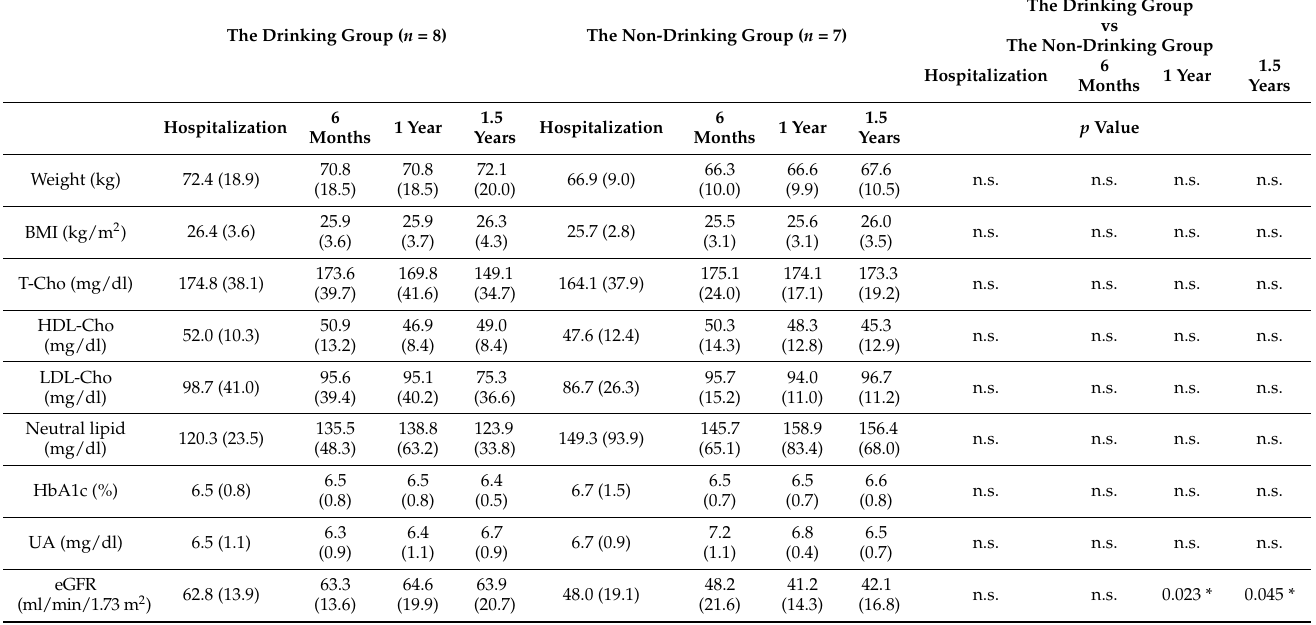
Table 5. Changes in anthropometry and blood biochemical examination (the drinking group and non-drinking